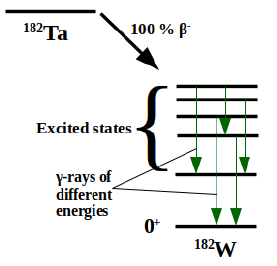
Figure 2. Schematic gamma transition scheme of 181 Ta.